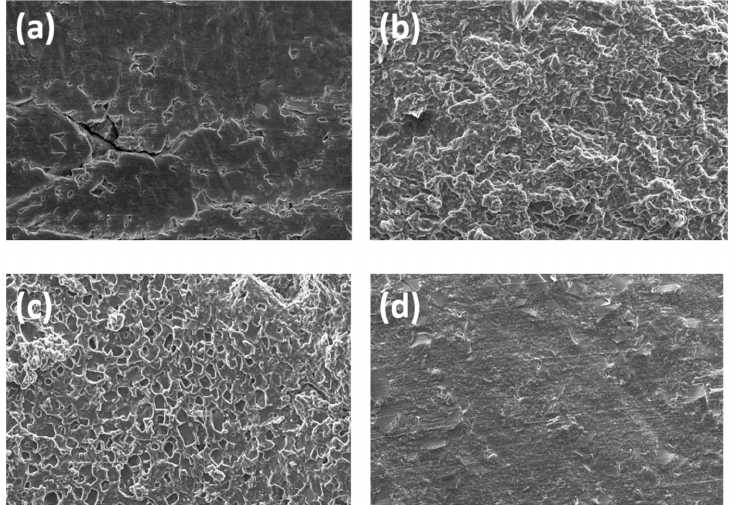
Figure 4. Photographs of elastomer sheets’ surfaces by FE-SEM observations: ( a ) PGI1; ( b ) PGS1; ( c ) PGS2; ( d ) PGS3. Scale bars = 400 µm.